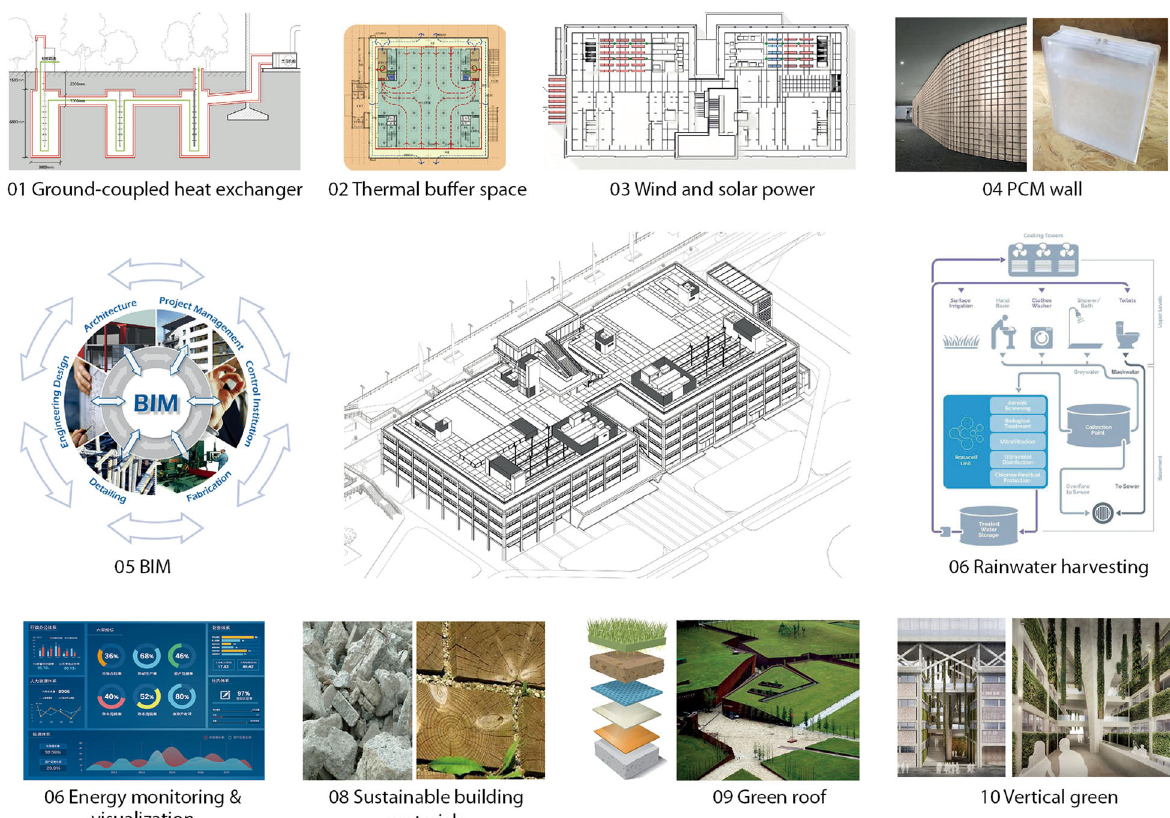
Fig. 17 Schematic proposal for the Yong ’ an Warehouse renovation (Source: 20a, 20b Archi-Union